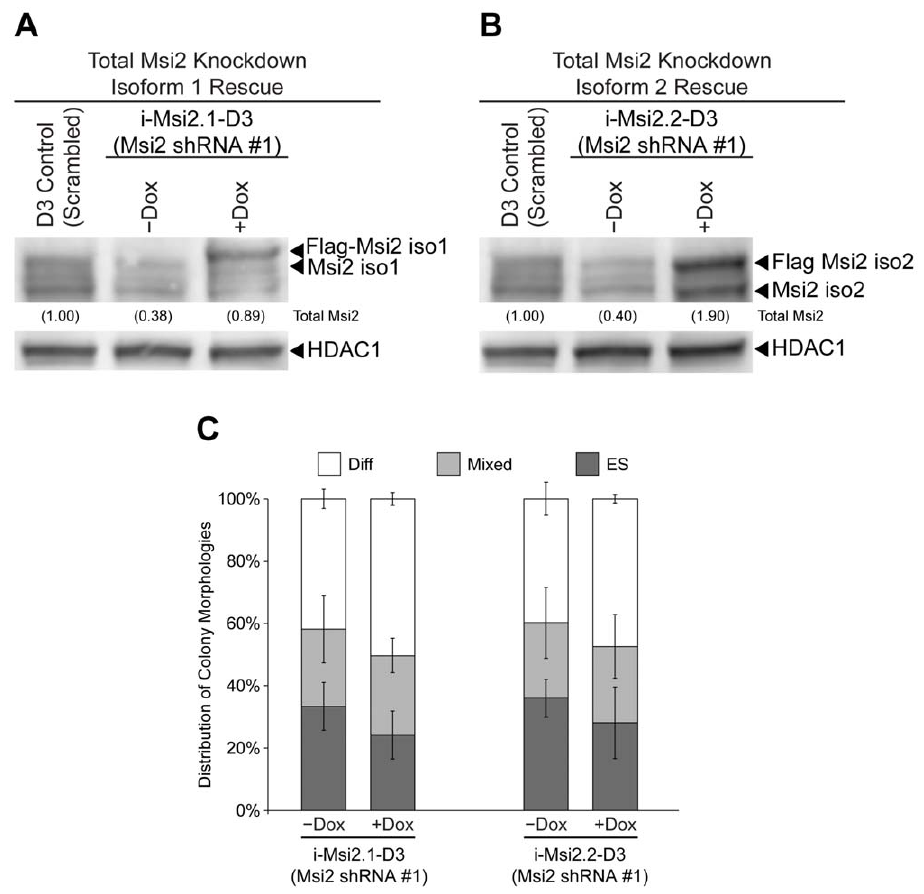
Figure 6. Rescue of Msi2 knockdown using an epitope-tagged overexpression construct. Cells engineered to overexpress Flag-tagged Msi2 isoform 1 or Flag-tagged Msi2 isoform 2, i-Msi2.1-D3 and i-Msi2.2-D3 respectively, were plated at 10,500 cells/cm 2 in the presence or absence of 2 m g/ml Dox. Cells were infected with lentiviral constructs that express Msi2 shRNA # 1 for 48 hours. One day later, the cells were subcultured at 600 cells/cm 2 in the continued presence or absence of 2 m g/ml Dox and the remaining cells harvested for protein extracts. Western blot analysis was used to monitor the levels of Msi2 in i-Msi2.1-D3 ( A ) or i-Msi2.2-D3 ( B ) stably infected with shRNA # 1 lentivirus in the presence or absence of 2 m g/ml Dox. D3 ESC infected with the lentiviral vector that expresses the scrambled shRNA was used as a control. ( C ) Effects of inducing Flag-tagged Msi2 isoform 1 (left) or Flag-tagged Msi2 isoform 2 (right) on the cloning efficiency of D3 ESC following Msi2 knockdown. Six days following subculture, two observers unaware of sample designation scored colonies as ESC, Mixed or differentiated (Diff). The error bars are standard deviation between the average percentages as scored by the two observers. This experiment was repeated twice and similar results were obtained.